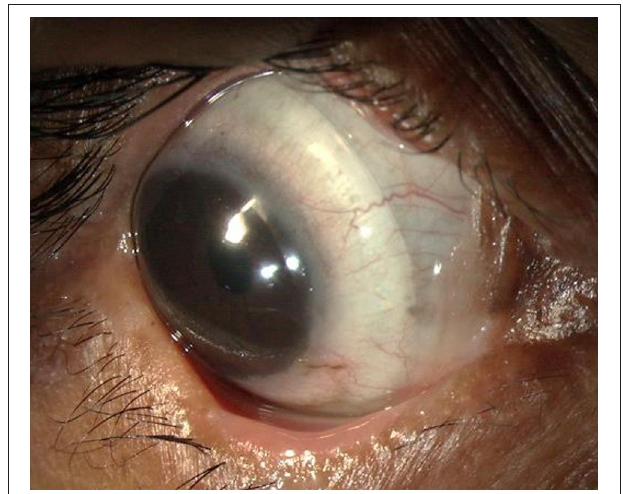
FIGURE 1 | Scleral lenses [prosthetic replacement of ocular surface ecosystem (PROSE) lenses] used for management of severe dry eye in a patient with chronic ocular sequelae post Stevens-Johnson syndrome/toxic epidermal